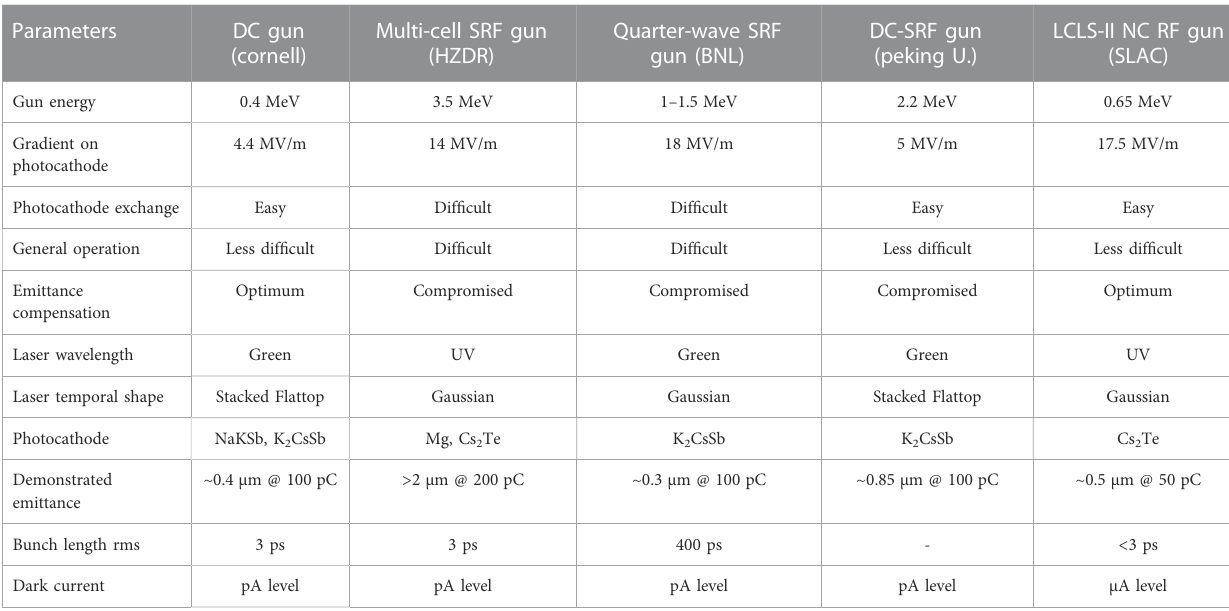
TABLE 2 Representative CW gun parameters and